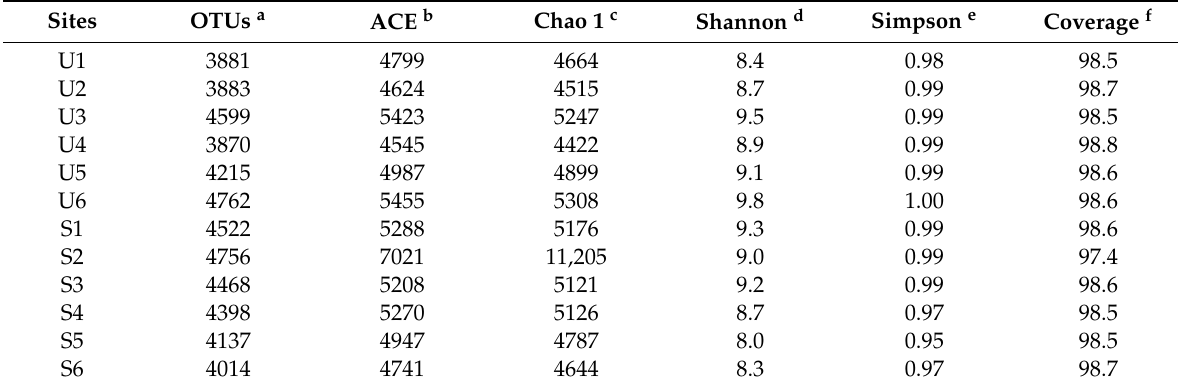
Table 2. Bacterial richness and diversity characteristics of the bacterial sequences from pyrosequencing at each sample